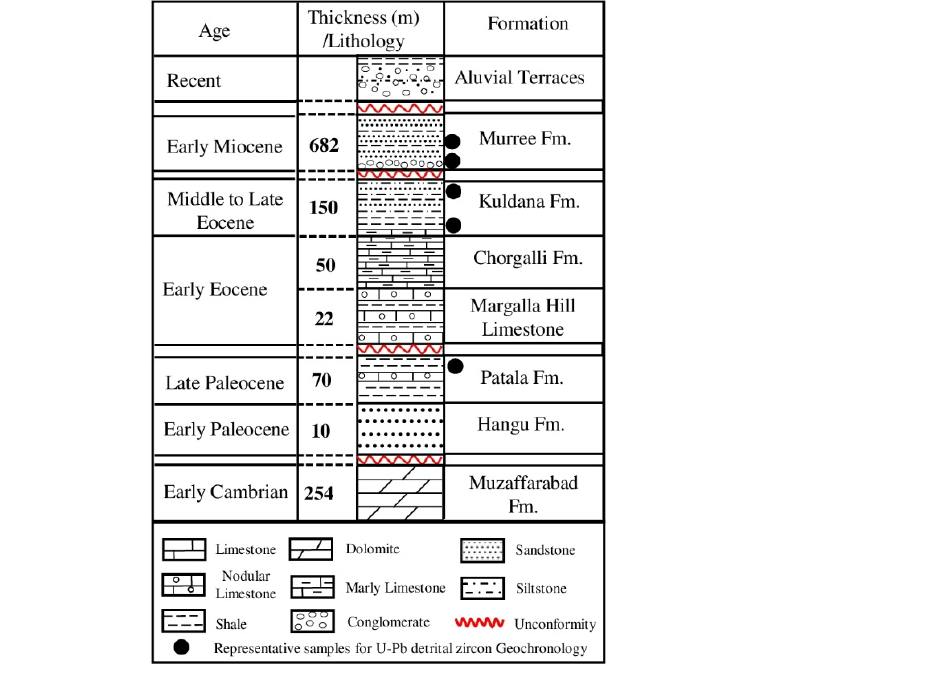
Figure 2. Stratigraphic column of the studied area showing position of the samples collected for U-Pb geochronology.